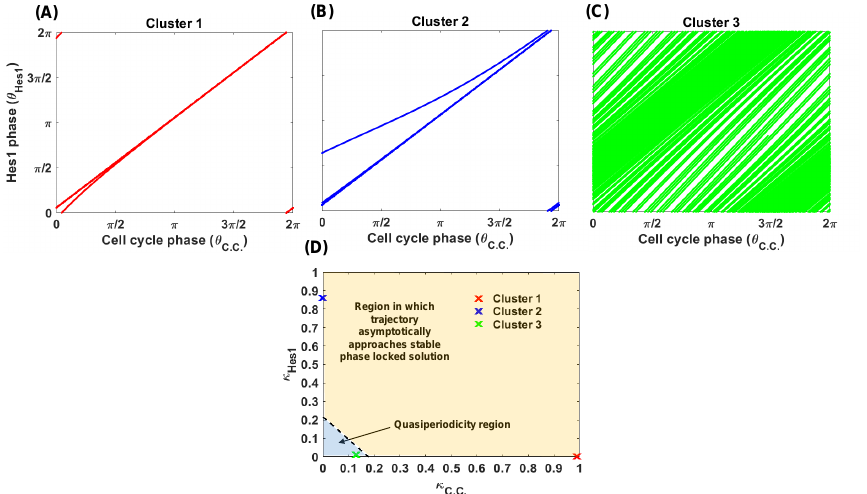
Figure 9. ( A – C ) Long-term solutions of Equation (5) with optimal parameter values found in Figure 8 for clusters 1, 2 and 3, respectively. ( D ) Two-dimensional κ C.C. × κ Hes1 parameter space with optimal parameter values found in Figure 8 for clusters 1, 2 and 3 plotted as a red, blue and green x , respectively. The yellow region represents parameters where the condition of Equation (7) is met and when trajectories will asymptotically reach a stable phase-locked solution. The blue region represents the region where Equation (7) is not met, and quasiperiodicity will occur.